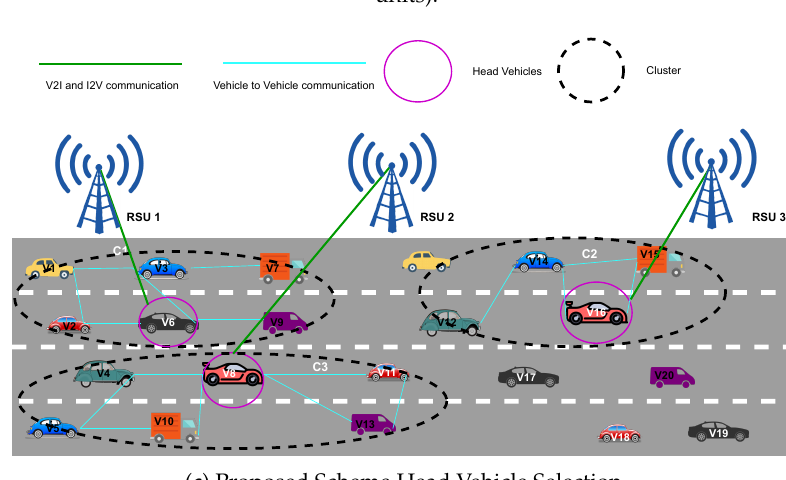
( b ) Multiple head vehicle selection and Information sharing with RSU (roadside units).